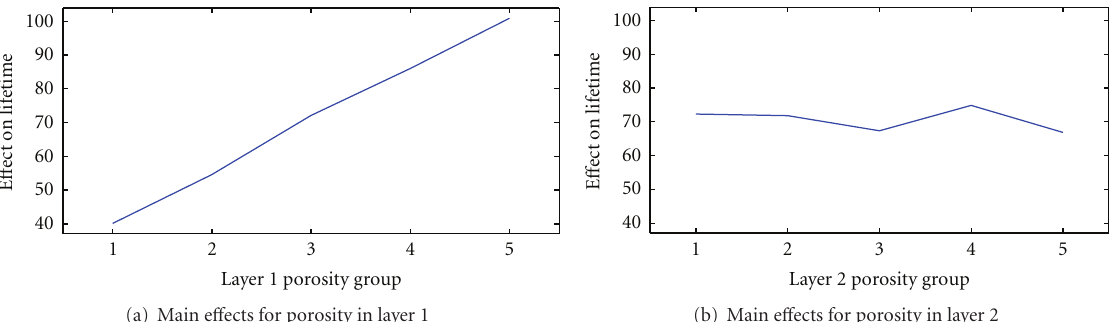
Figure 7: Main e ff ects plots for the lifetime objective for η 1 and η 2 .